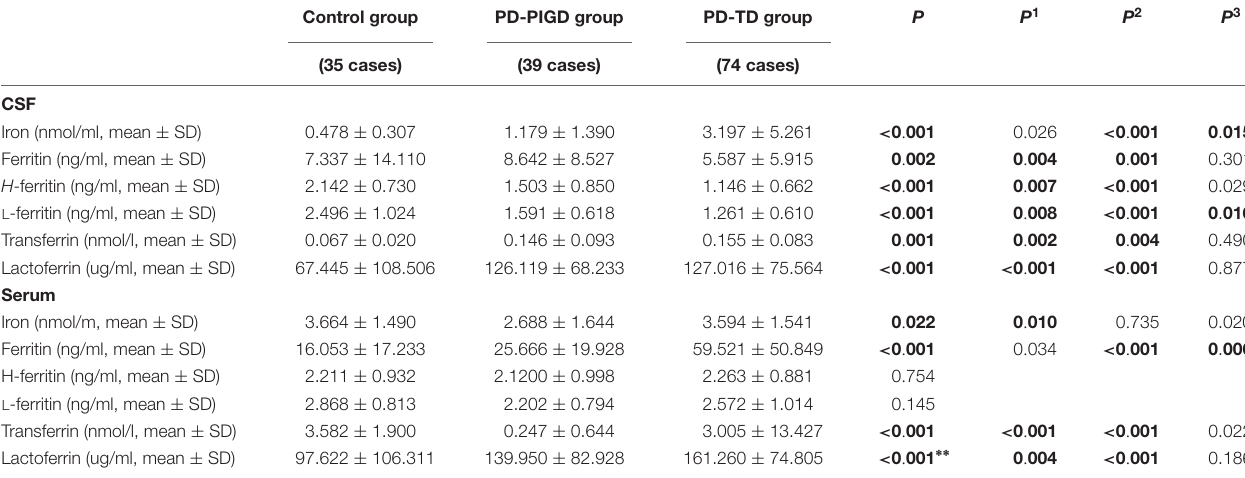
TABLE 2 | The levels of iron and its metabolism-related proteins in CSF and serum from the control, PD-PIGD and PD-TD groups. Control group PD-PIGD